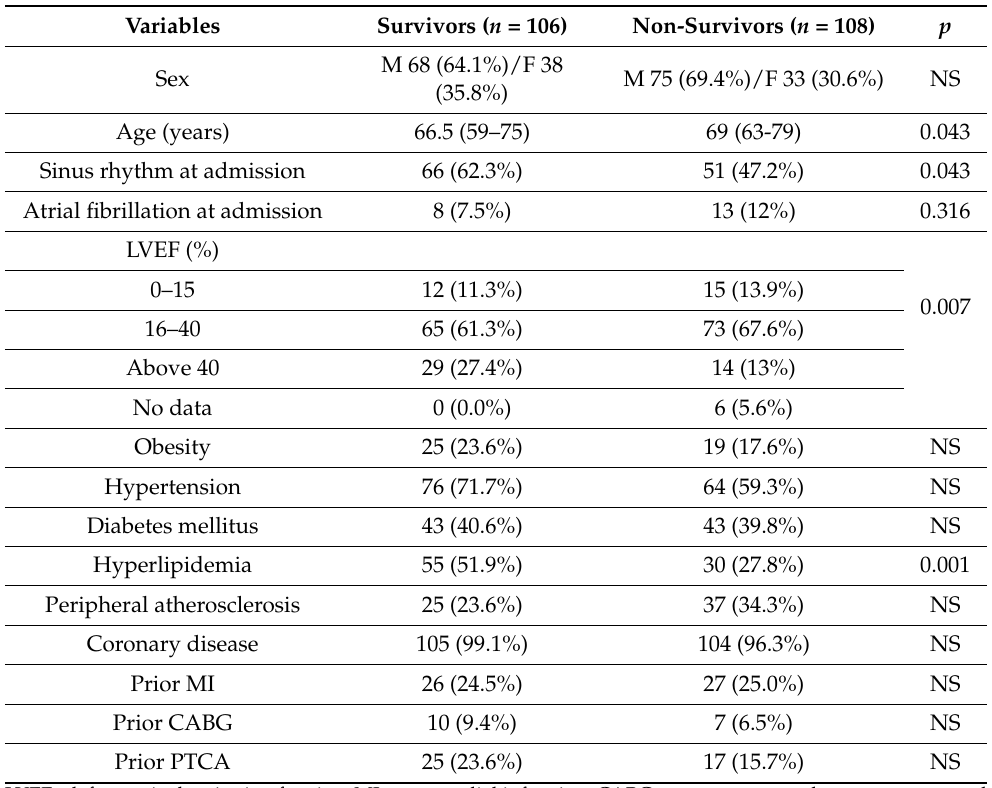
Table 1. Characteristics of the study